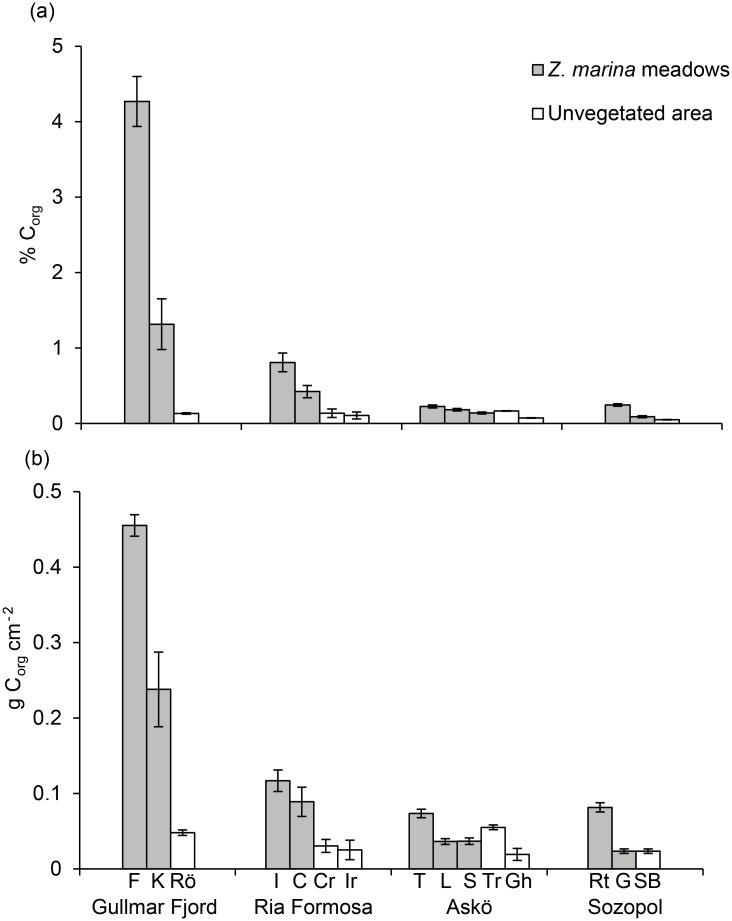
Sedimentary organic carbon content in Z. marina meadows and unvegetated areas.Mean (±SE) percent organic carbon (% Corg) (a) and g Corg cm-2 (b) in sediment (for 0–25 cm sediment depth). The % Corg is presented as a mean of the content for the top 25 cm sediment, while carbon per unit area (g Corg cm-2) is the total (accumulated) amount of carbon in the top 25 cm of sediment. For full names of the sites see Table 1.